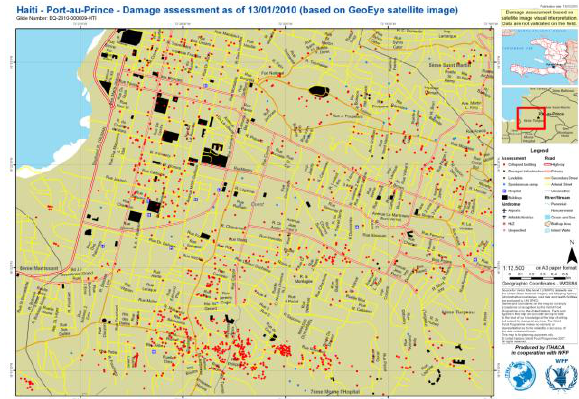
Figure 3. Haiti – Port-au-Prince: damage assessment map as of 13 Jan 2010 (based on GeoEye satellite image)